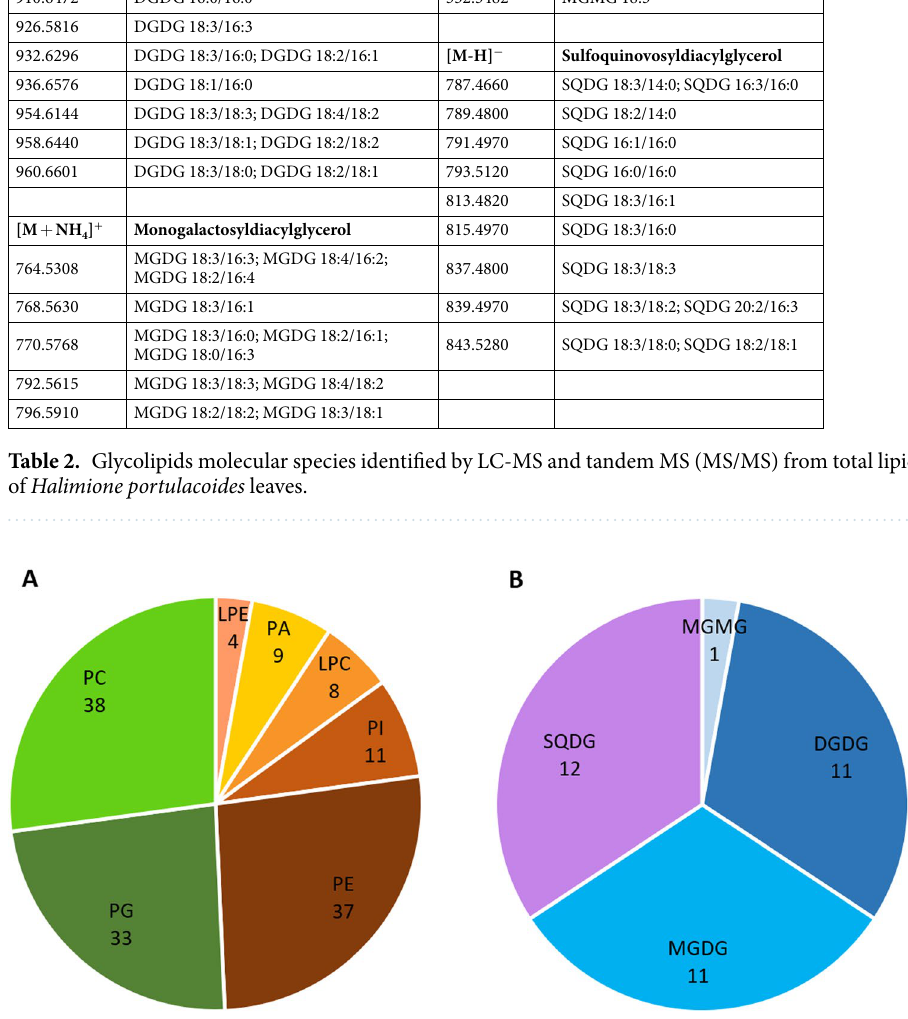
Figure 3. Number of ( A ) phospholipids and ( B ) glycolipids molecular species identified in the lipid extract of Halimione portulacoides leaves by MS/MS. DGDG – digalactosyldiacylglycerol; LPC